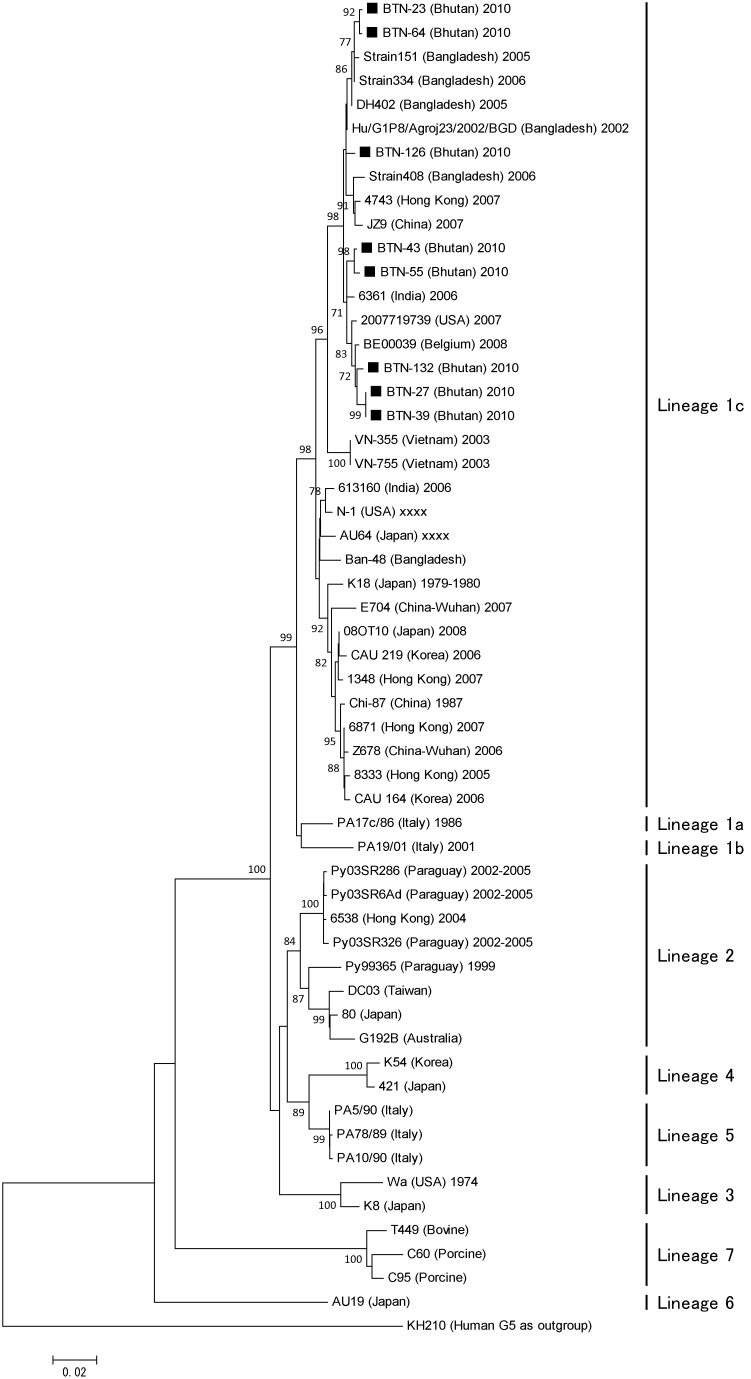
Phylogenetic tree constructed based on the deduced amino acid sequences of the VP7 genes of G1 strains.Bhutanese strains are indicated by black squares, which are followed by the strain numbers. Human rotavirus KH210 (G5) was used as an outgroup. The numbers adjacent to nodes represent the bootstrap values; values <70% have not shown. The scale bar shows the genetic distance, which is expressed as amino acid substitutions per site. The DNA Data Bank of Japan/European Molecular Biology Laboratory/GenBank accessions numbers are: AB905455 (rotavirus strain BTN-23), AB905456 (BTN-64), AB905457 (BTN-55), AB905458 (BTN-126), AB905459 (BTN-43), AB905460 (BTN-132), AB905461 (BTN-27), and AB905462 (BTN-39).